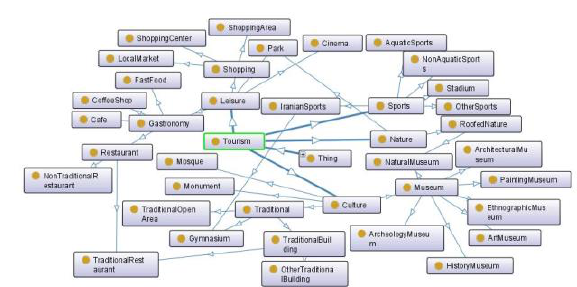
Figure 2. The proposed knowledge domain ontology